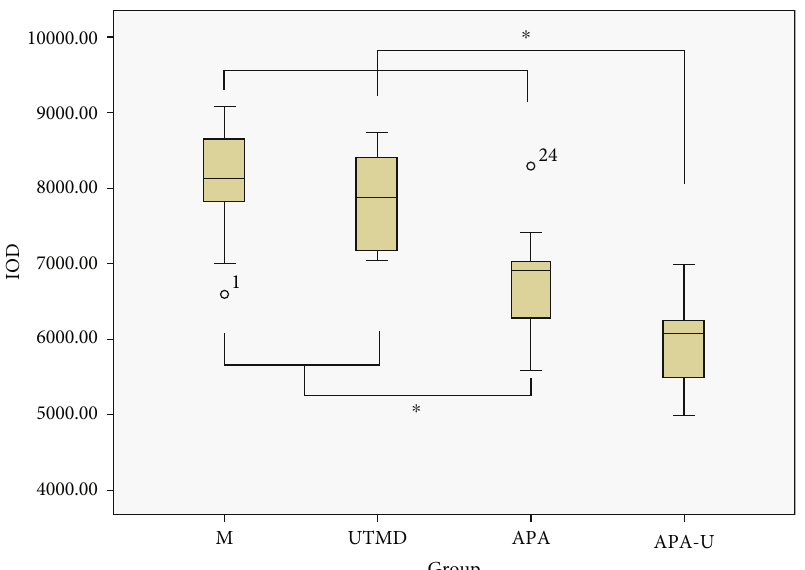
Figure 5: The VEGF IOD in di ff erent groups. Note: asterisks indicate the pairs having statistically signi fi cant di ff erences in the ANOVA test followed by LSD t -test.